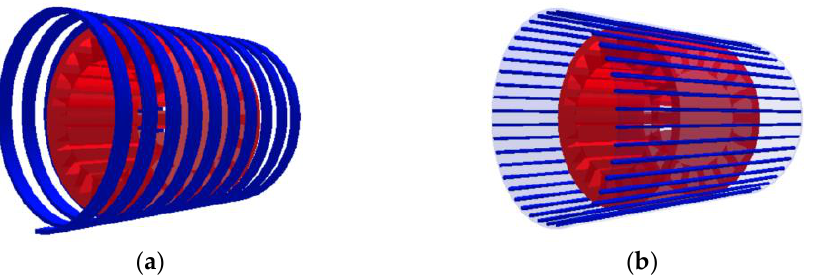
Figure 11. Common frame liquid cooling channel configurations (end connection of channel is not presented) in [54]. ( a ) Spiral. ( b ) Axial.